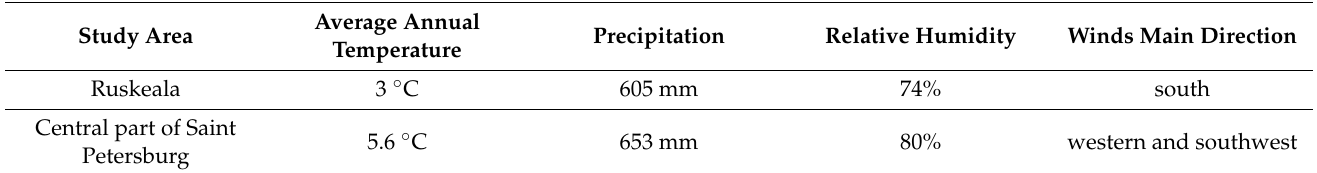
Table 1. Climatic features of sampling